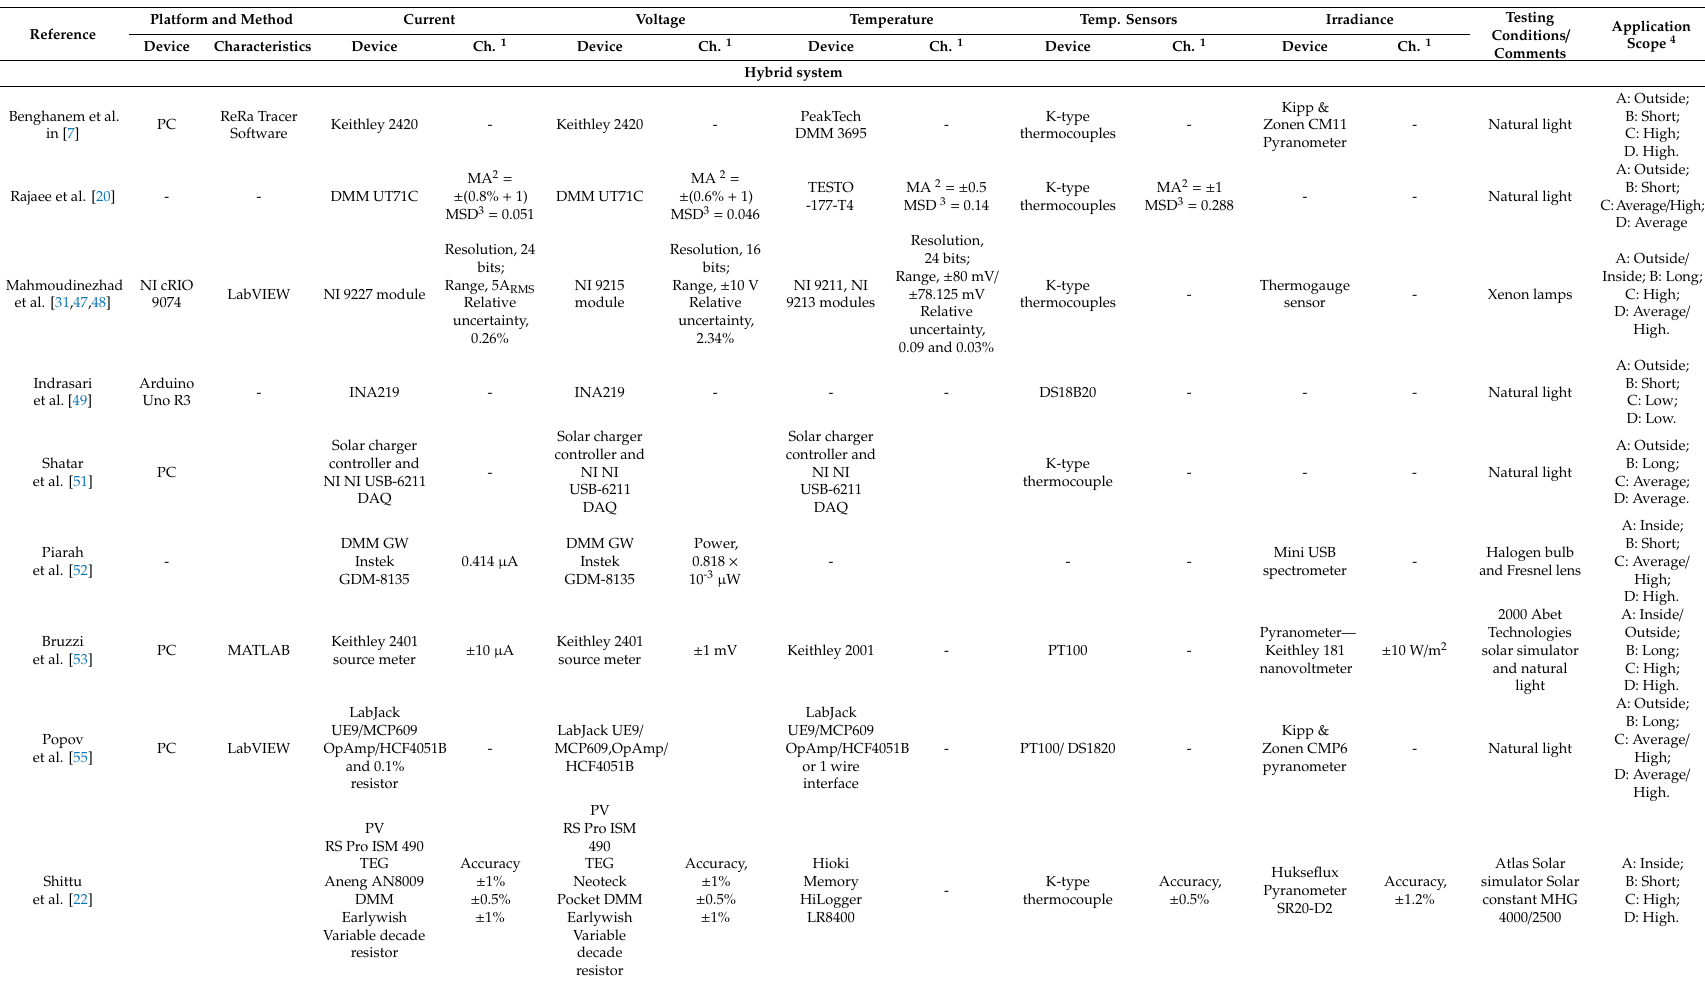
Table 1. Used instruments.